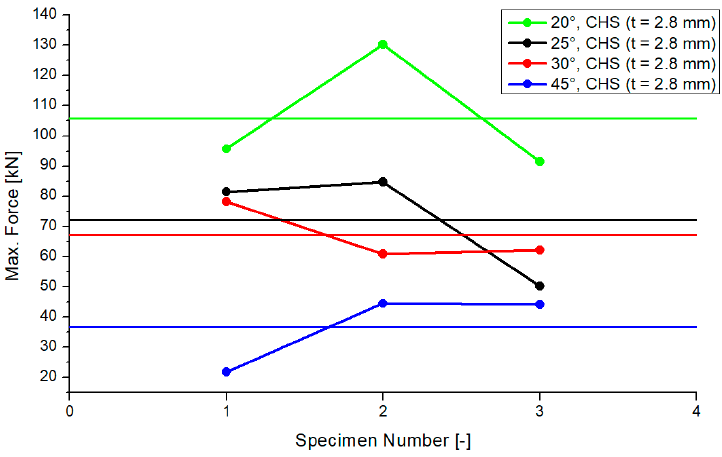
Figure 7. Results of the maximum compression force, CHS t = 2.8 mm.